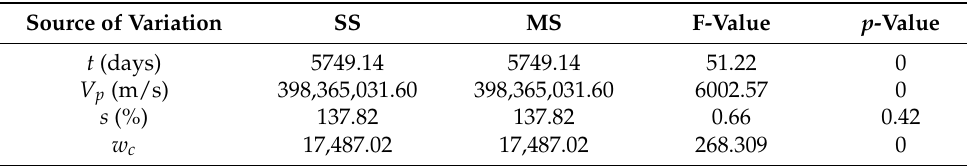
Table 8. Analysis of variance among variables on f (cid:48) c . Source of Variation